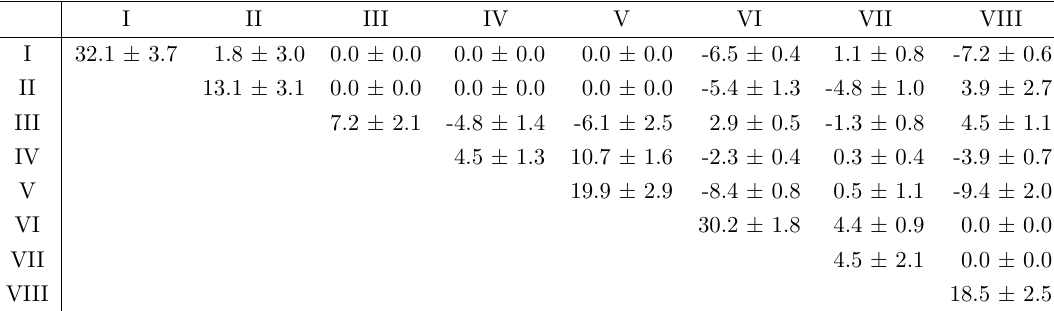
Table 6 . Interference between amplitudes, in unit of % of total amplitude. I denotes D + II D + → K + ρ (1450) 0 , III D + s